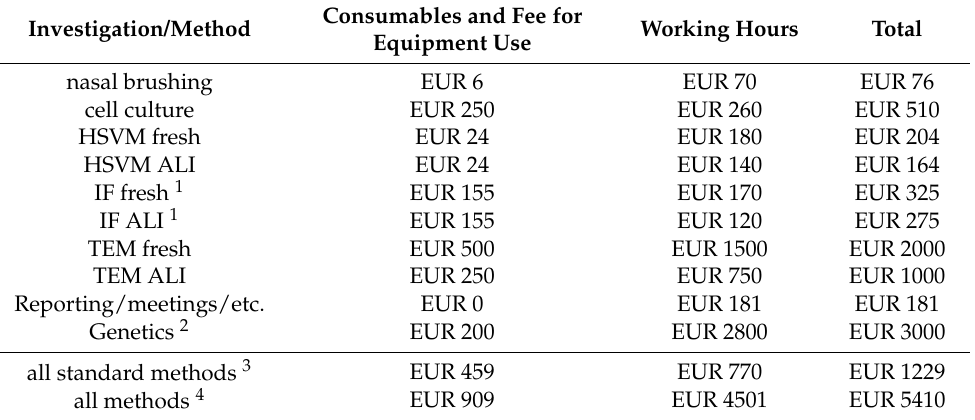
Table 4. Overview of the costs for the different methods. These costs only include running costs, such as consumables, fee for using microscopes and working hours, but no initial set up costs (e.g., purchase of equipment) and neither costs on the side from clinics or patients for the visits (of which more are needed if only fresh material is